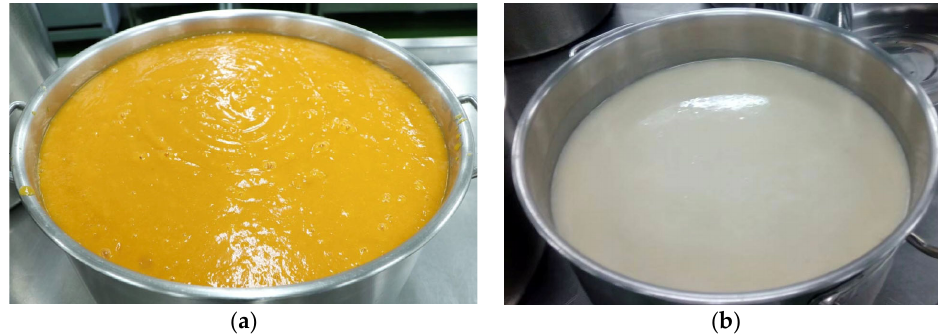
Figure 1. Mango purée ( a ) and mangosteen purée ( b ). Figure 1. Mango pur é e ( a ) and mangosteen pur é e ( b